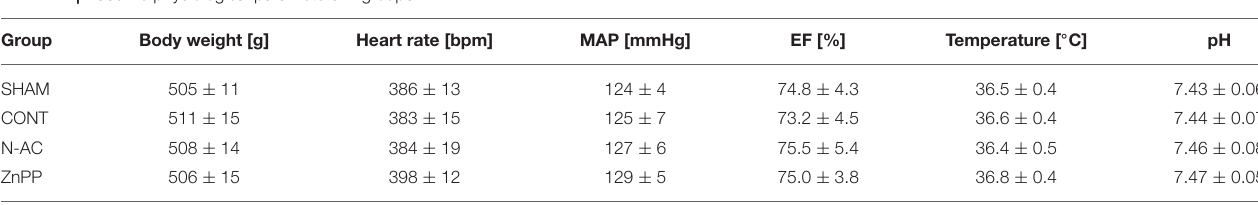
TABLE 1 | Baseline physiological parameters in